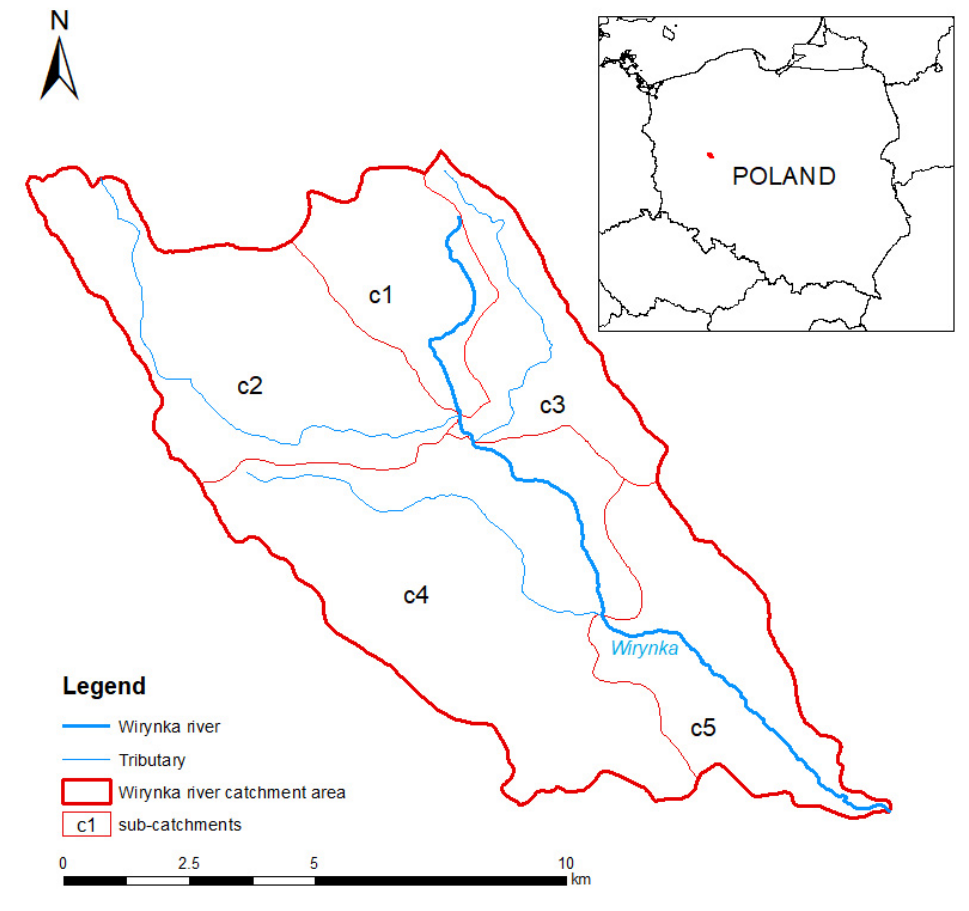
Figure 1. Location of the Wirynka catchment with the division into sub-catchments.